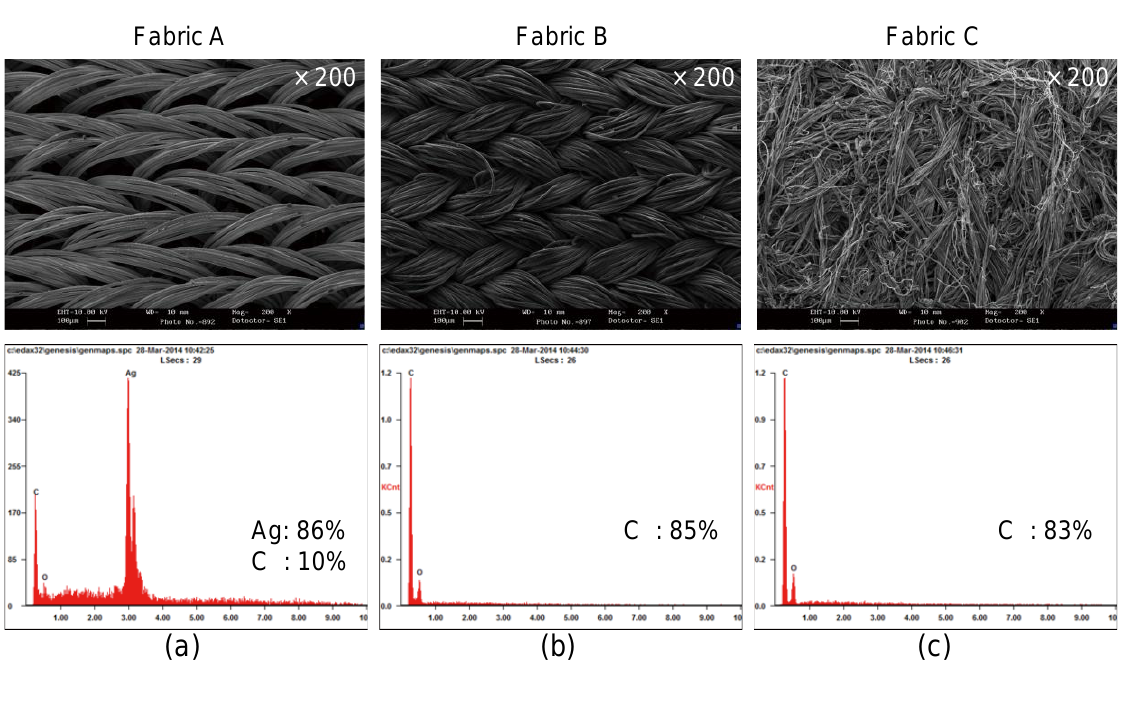
Figure 1 . SEM images (×200) and EDS microanalyses of three conductive fabrics. Fabric A was plated with silver. Fabrics B and C were coated with carbon. Figures in the upper and lower rows are the SEM images and the EDS microanalysis results,